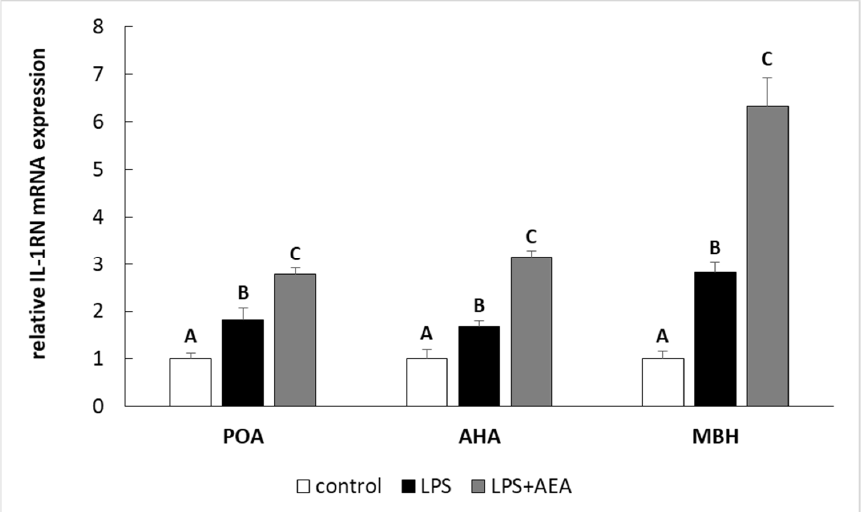
Figure 3. The effect of intravenous (i.v.) anandamide (AEA) injection (10 µ g/kg; i.v.) and lipopolysaccharide (LPS)-induced inflammation (400 ng/mg; i.v.) on the relative interleukin 1 antagonist (IL-1RN) mRNA level in preoptic area (POA), anterior hypothalamus (AHA), and medial basal hypothalamus (MBH) normalized to the mean expression of three reference genes ( GAPDH , HDAC1 , ACTB —see Table 2). All data are presented as the mean value ± S.E.M. Different letters indicate significant ( p < 0.05) differences according to a one-way ANOVA followed by Fisher’s least significance test.